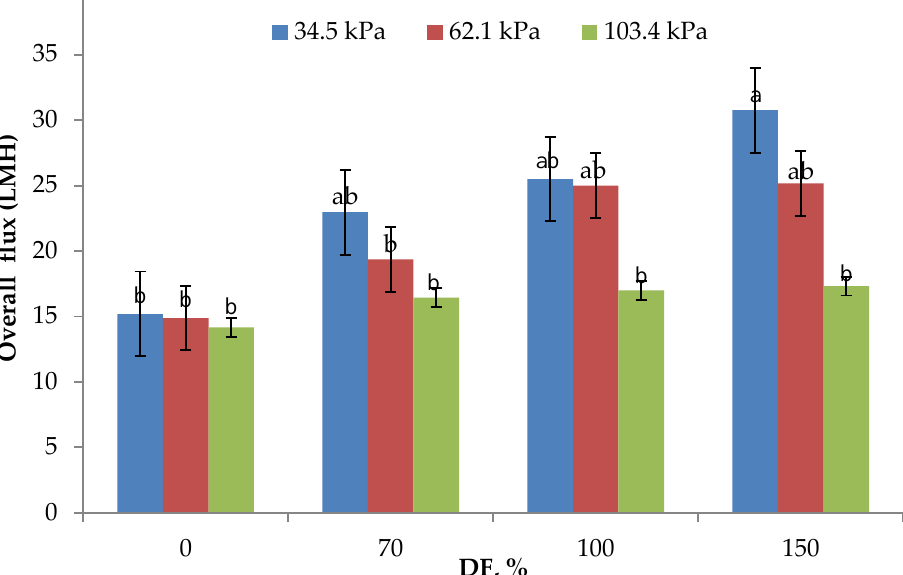
Figure 2. Overall flux means ( n = 3) obtained from the lab-scale studies. All experiments were conducted at 24 °C and 800 mL feed was concentrated to a final volume of 200 mL resulting in a fourfold volume reduction (VR). DF is diafiltration water added, measured as a percentage of original feed volume. a,b Means not sharing the same letter are significantly different ( p < 0.05).